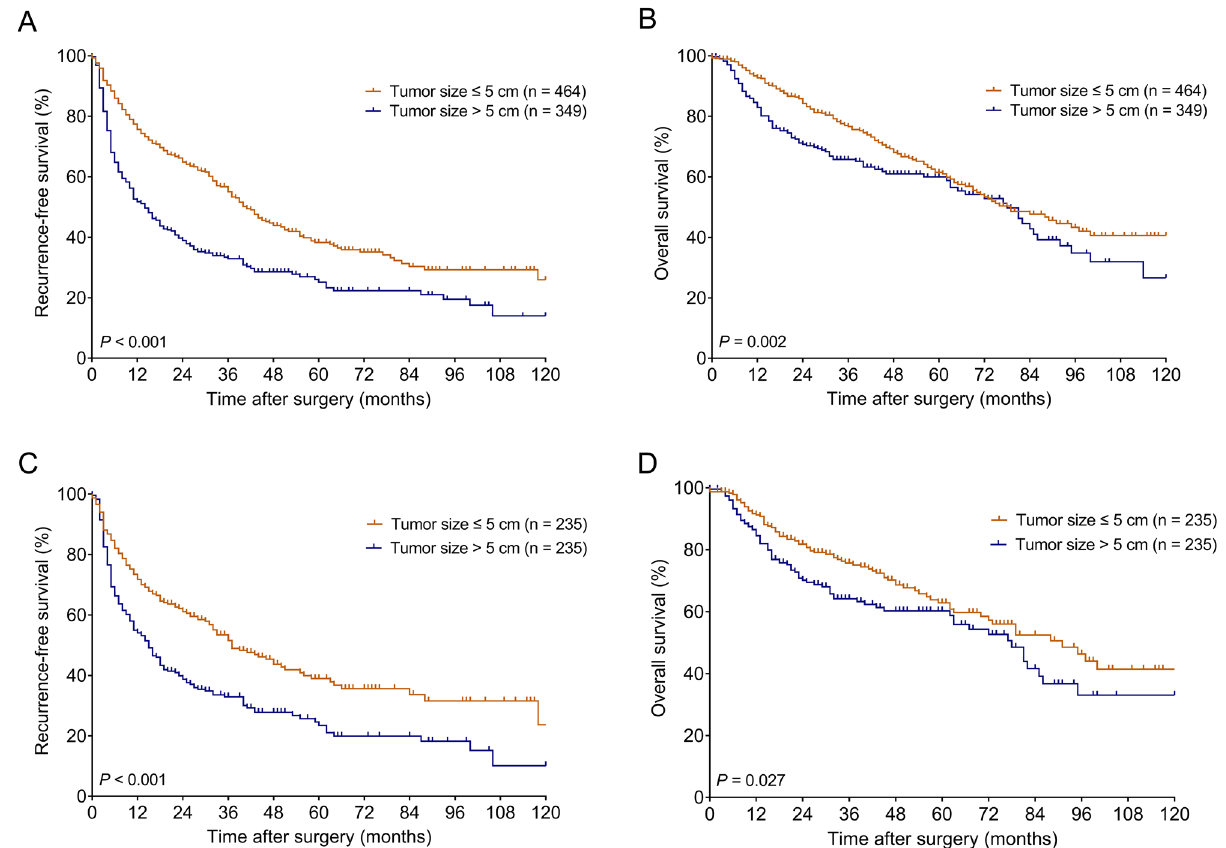
Figure 1. Kaplan–Meier survival curves in the groups stratified by tumor size in the entire cohort ( A , B ) and in the PSM cohort ( C , D ). ( A , C ) RFS curves. ( B , D ) OS curves. PSM propensity score matching, RFS recurrence- free survival, OS overall survival.